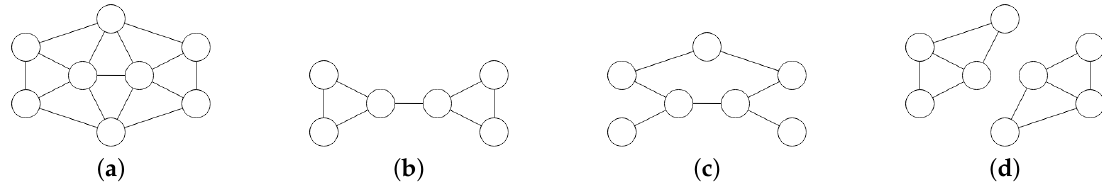
Figure 1. An undirected graph with induced and non-induced subgraphs. ( a ): The original undirected graph with 8 vertices and 15 edges. ( b ): An induced subgraph. ( c ): A non-induced subgraph. ( d ): A non-connected subgraph.